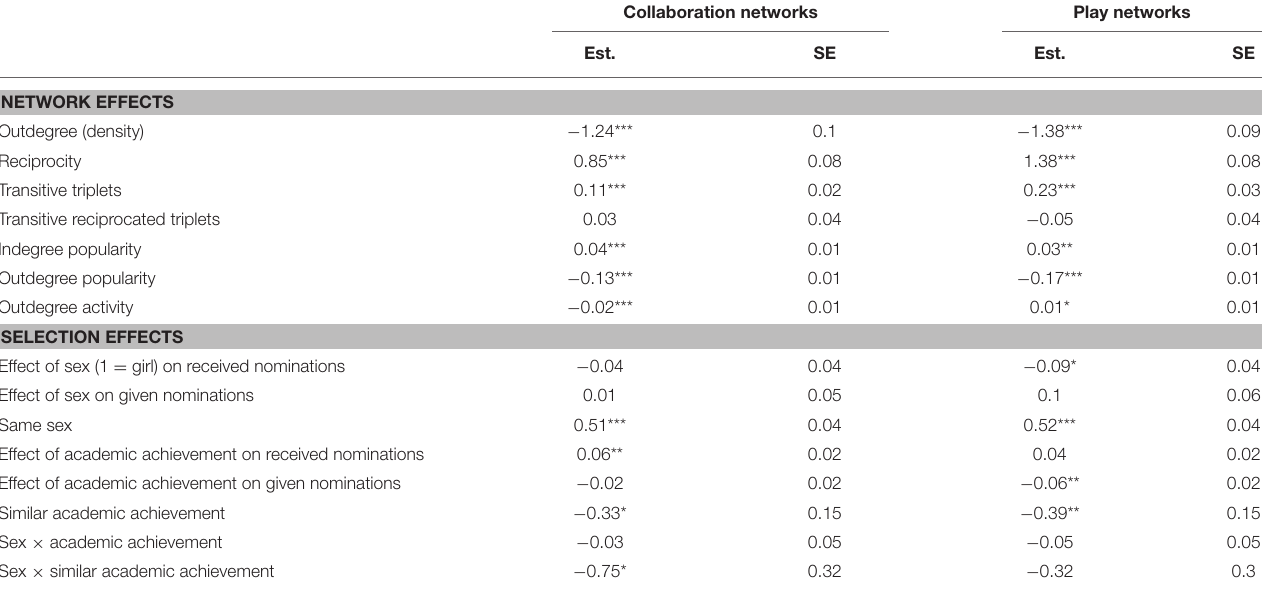
TABLE 2 | Selection model for academic achievement and sex in the collaboration and play networks. Collaboration networks Play